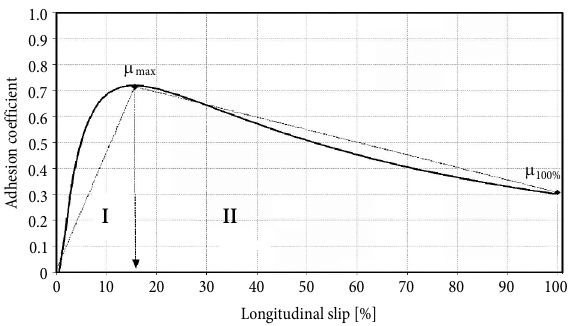
measurement results generated using SRT-4 device for investigation of two road stretches (X1 and X2) at in- tervals of 100 m is presented in Table 3. Stretch X1 is characterized by high level of road adhesion maintained over the selected speed v , while stretch X2 is character- ised by medium level.